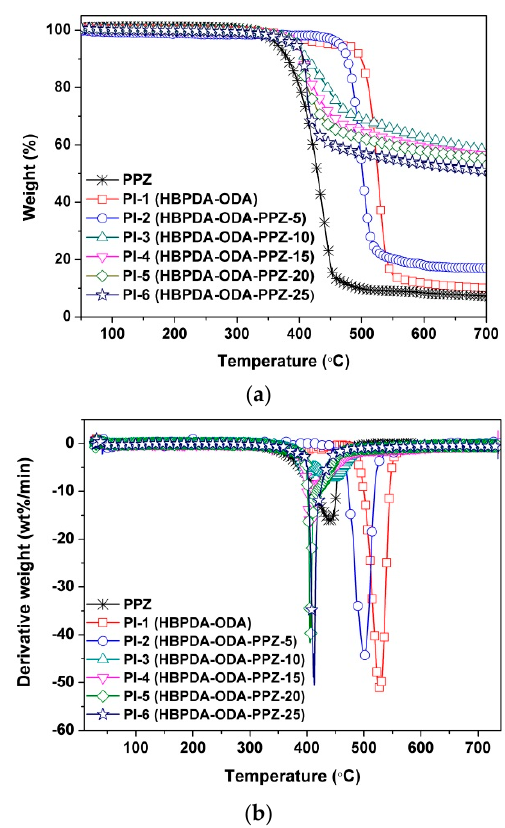
Figure 7. Thermal decomposition behaviors of PI films in nitrogen. ( a ) TGA; ( b ) DTG.